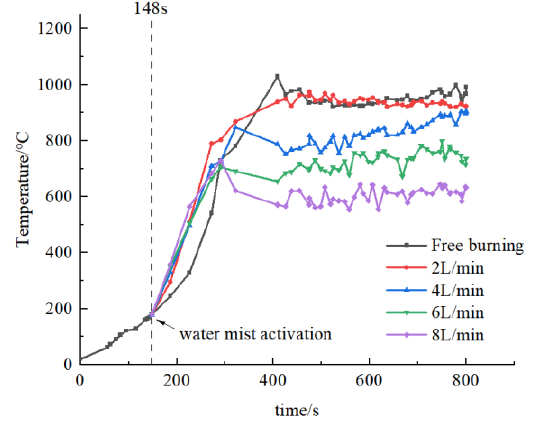
Figure 4. Temperatures measured by thermocouple A at different spray flow rates. The profiles of the flame center temperatures (480 s) when the fire field reaches stable combustion at different spray flow rates are shown in Figure 5. The temperature values at 200, 400, 600, and 800 s are shown in Table 5. Table 5. Temperatures at 200, 400, 600, and 800 s at different water-mist flows.